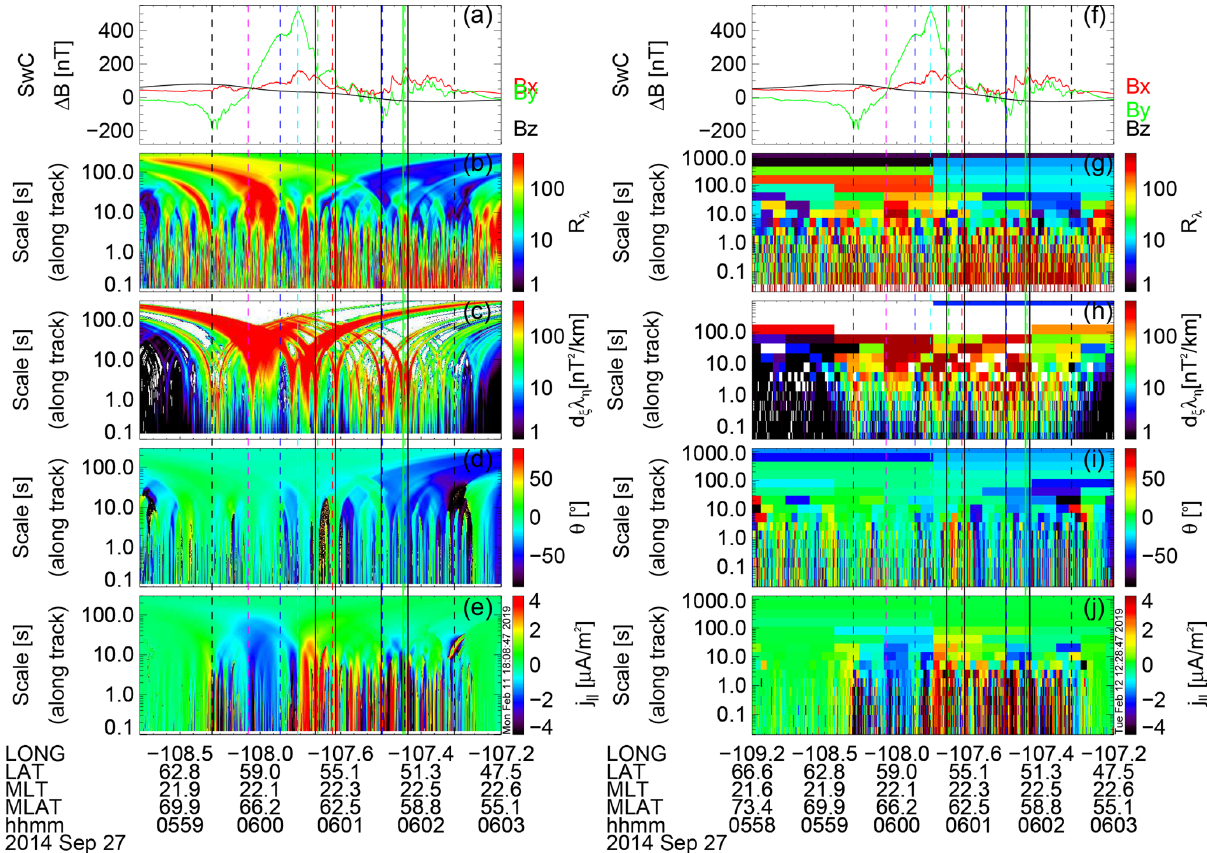
Figure 14. Same panels as in Fig. 5. The vertical dashed lines indicate the FAC segments or intervals of small-scale FACs. The vertical solid lines indicate the central times of small-scale downward (black) and upward (green) FAC elements for which we show the sections in Fig.